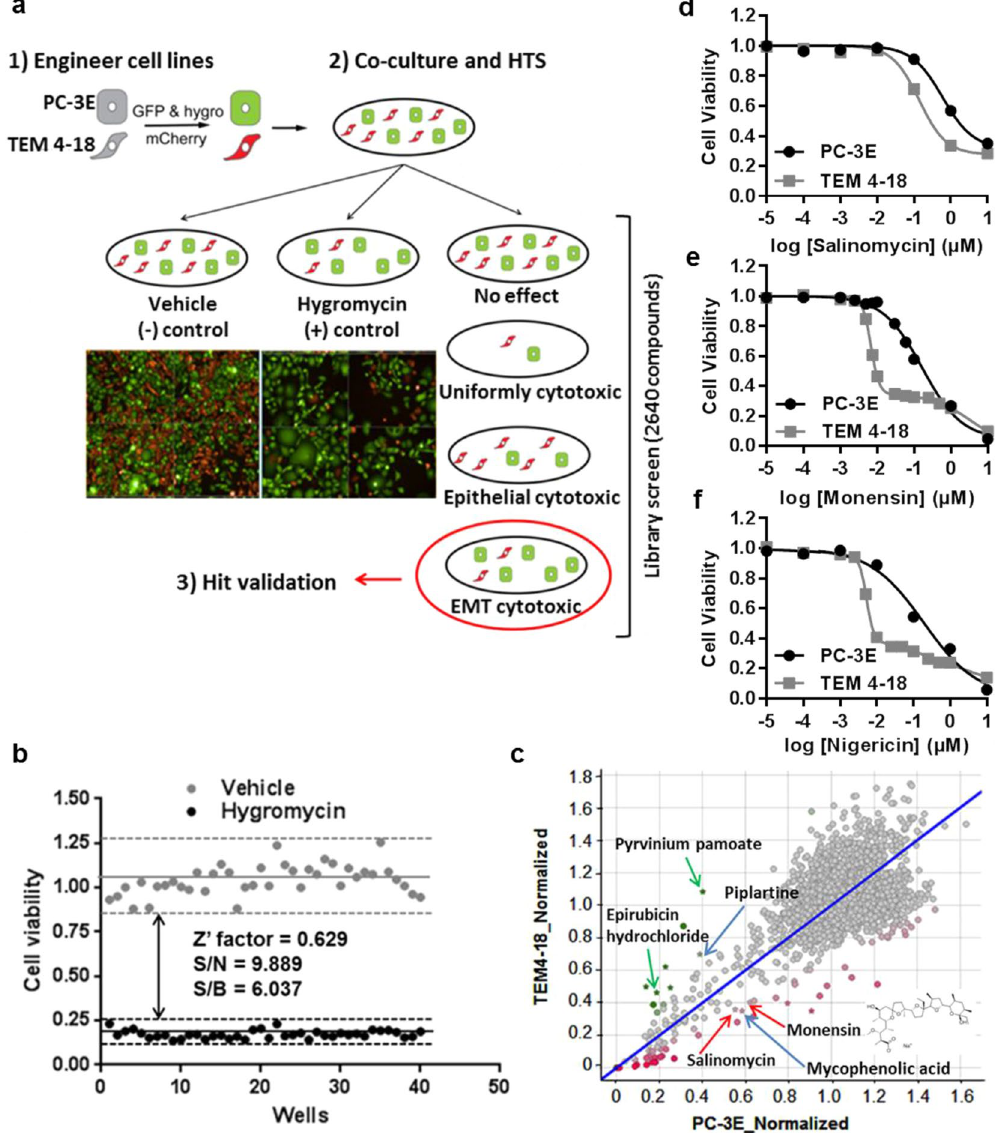
Figure 1. High content screen for EMT-selective compounds. ( a ) High content screen design. ( b ) Assay performance was assessed with a half-half plate using following parameters: the signal-to-noise (S/N) ratio = ( µ n − µ p)/SDn, the signal-to-background (S/B) ratio = µ n/ µ p, and the Z’ factor. ( c ) Results of the screen representing relative cell viability of TEM 4-18 mCherry (y axis) and PC-3E GFP (x axis) cells. Positions of selected compounds evaluated are indicated. ( d – f ) Cells cultured separately were treated for 72 h with serial dilution of salinomycin (n ≥ 5) ( d ), monensin (n ≥ 24) ( e ) or nigericin (n ≥ 5) ( f ). Relative cell viability was plotted against the logarithm of drug concentration. Data represent mean values ±